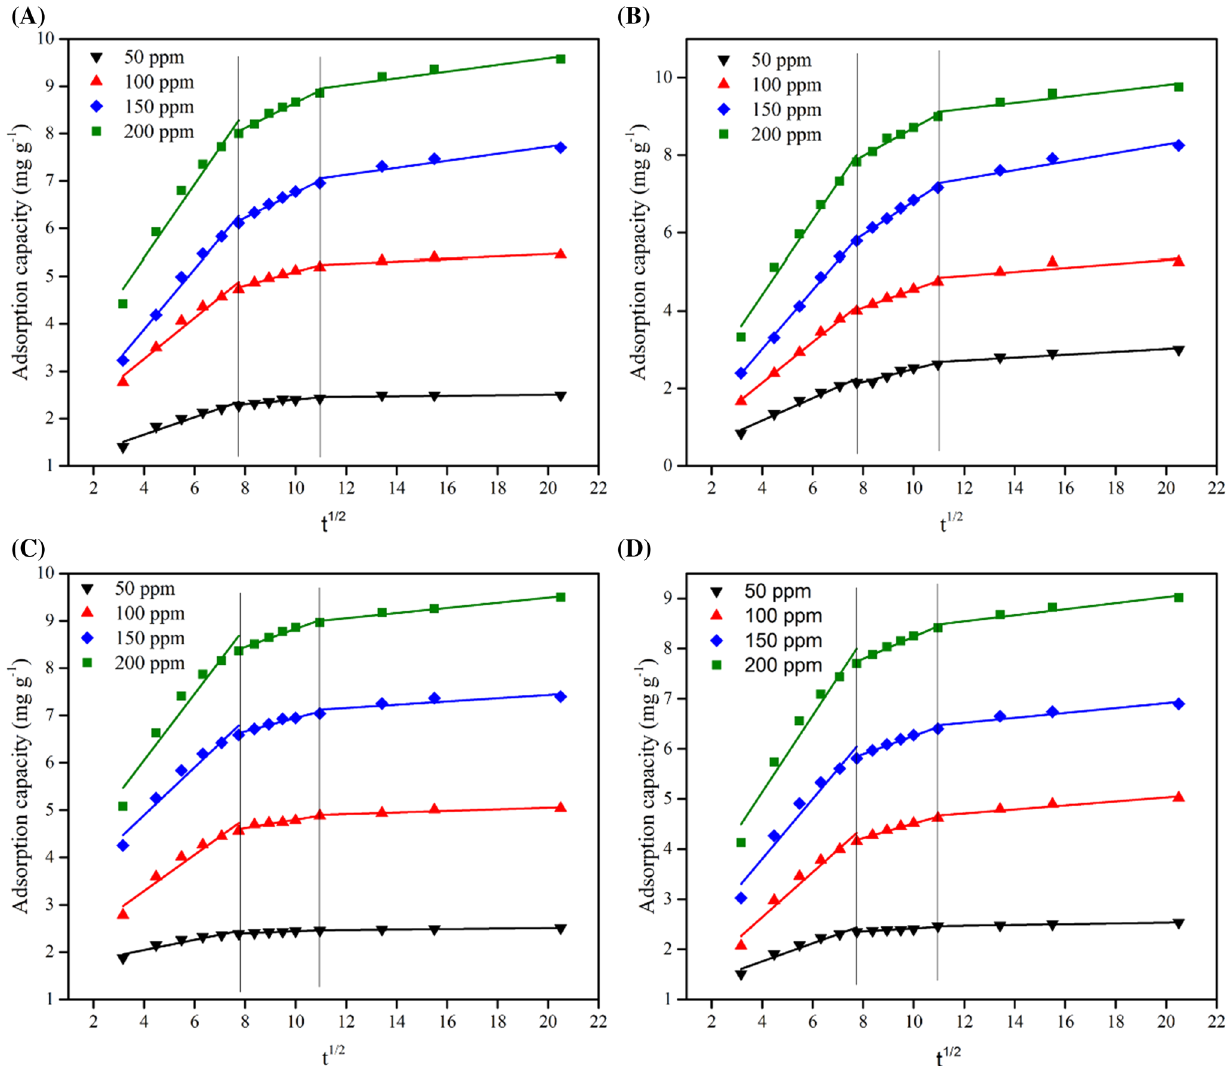
Fig. 4 Intraparticle diffusion model of the adsorption of DR5B ( a ), DB22 ( b ), DB71 ( c ), and ( d ) RB5 onto spent mushroom